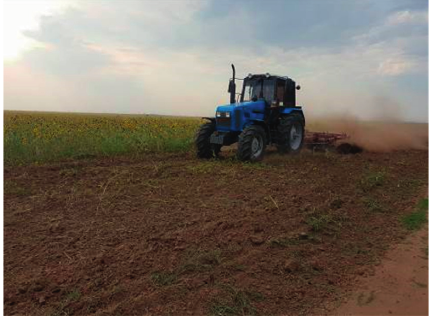
Figure 5: Sowing safflower silage into the soil. Table 5: Phytomeliorative effect of safflower on the content of chemical indicators of dark chestnut soils. Soil layer,